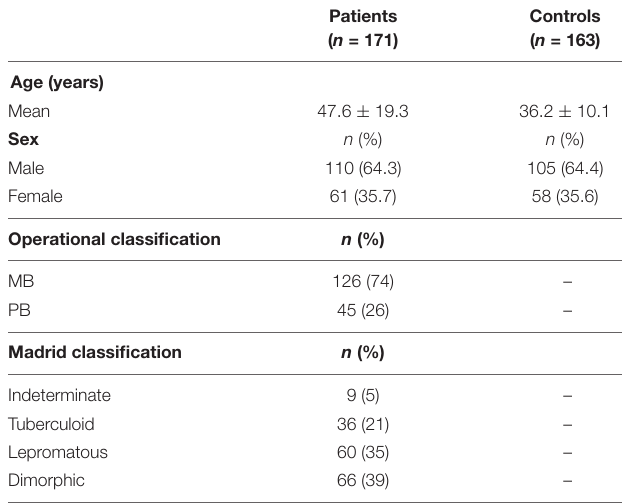
TABLE 1 | Characteristics of the study